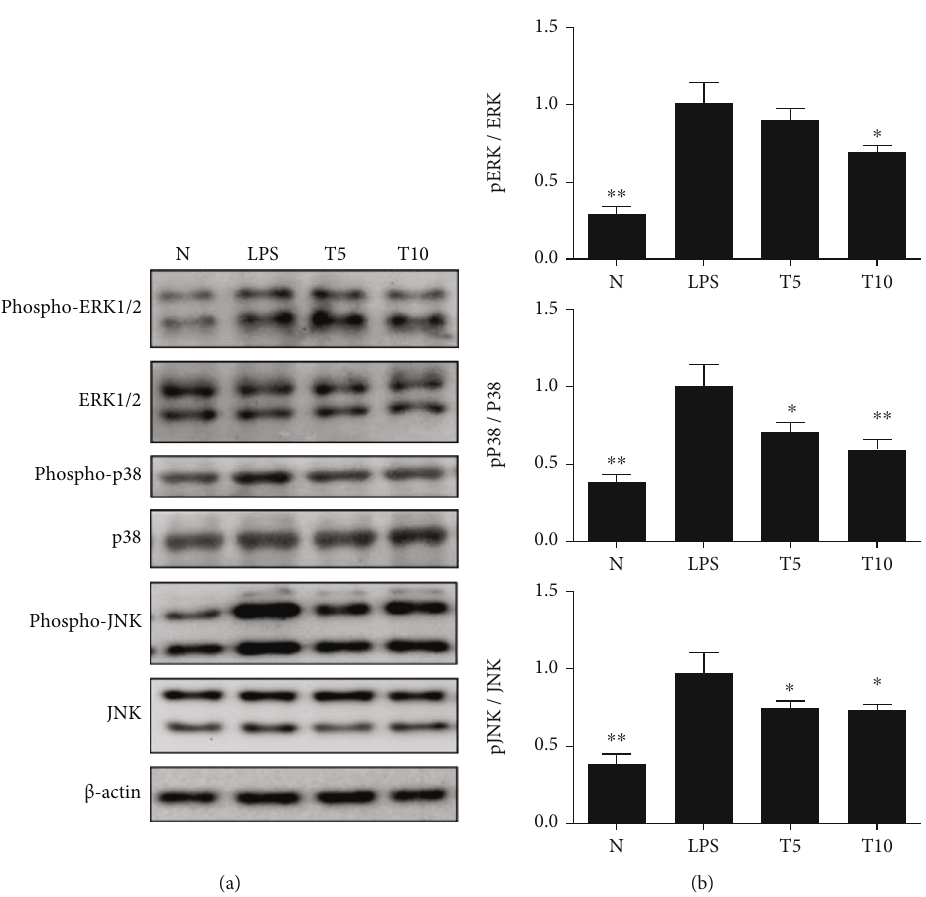
Figure 8: Tomatidine regulated the MAPK pathway in the lung of mice. (a) Tomatidine increased phosphorylation of ERK1/2, p38, and JNK protein expression. (b) The fold change in the expression of phosphorylated ERK1/2, p38, and JNK protein was measured relative to the expression of ERK1/2, p38, and JNK, respectively. Data are presented as the mean ± SEM . ∗ p < 0 : 05 and ∗∗ p < 0 : 01 vs. LPS group. N group: normal control mice; LPS group: LPS treatment only; T5 group: 5mg/kg tomatidine plus LPS; T10 group: 10mg/kg tomatidine plus